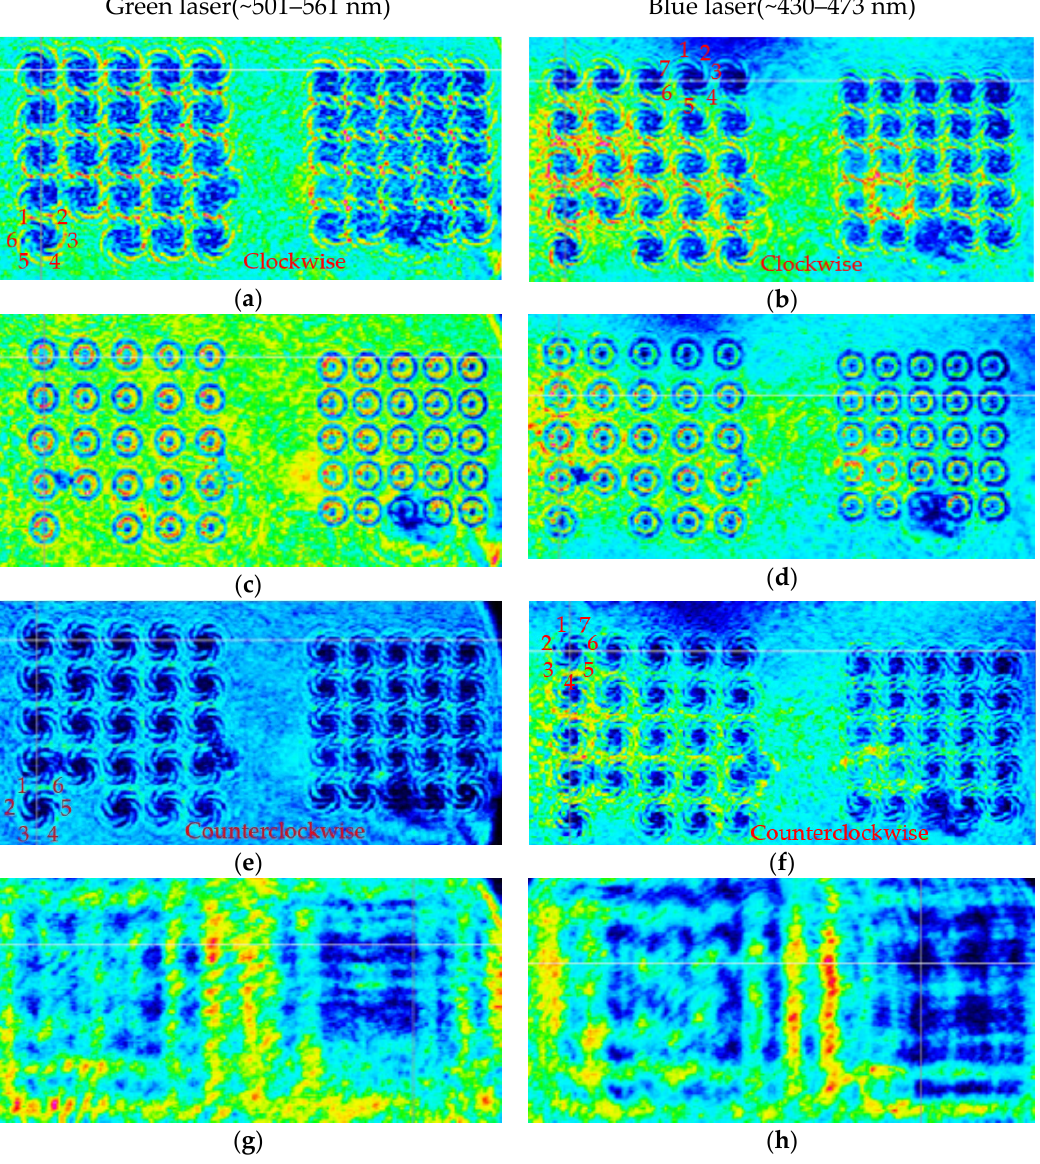
Figure 12. The light intensity distribution of the laser beams with a center wavelength in the range of 501–561 nm, when the distance is: ( a ) 300 μ m, ( c ) 390 μ m, ( e ) 500 μ m, and ( g ) 10,000 μ m, respectively. The light intensity distribution of the laser beams with a center wavelength in the range of 430–473 nm, when the distance is: ( b ) 300 μ m, ( d ) 380 μ m, ( f ) 500 μ m, and ( h ) 10,000 μ m, respectively.